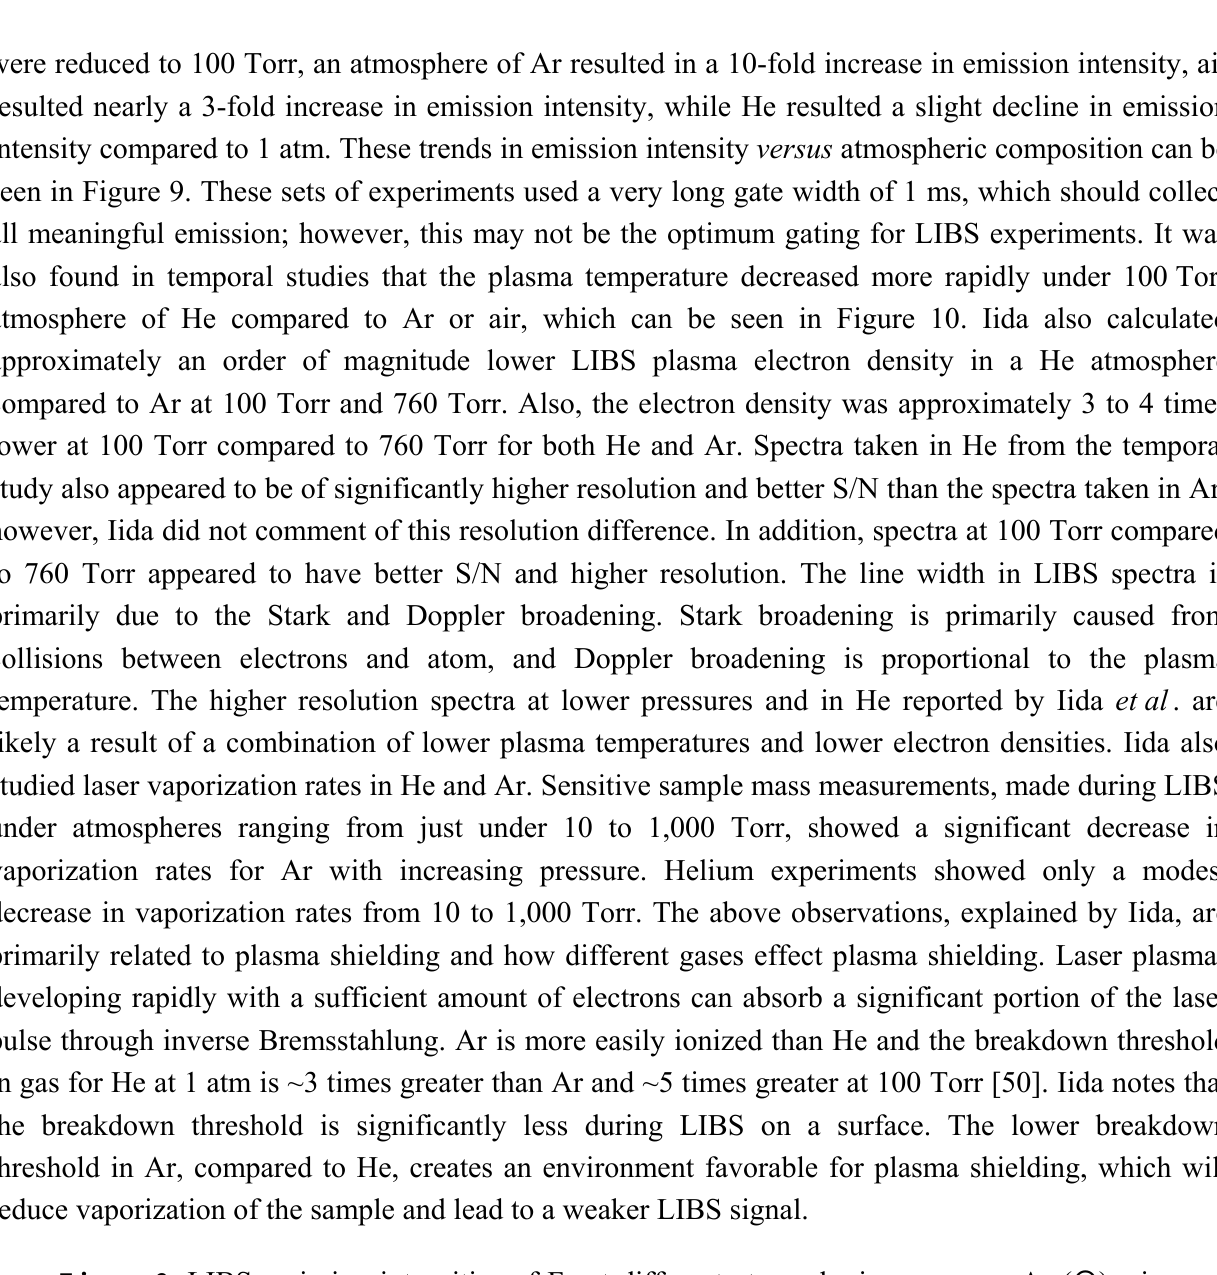
Figure 9. LIBS emission intensities of Fe at different atmospheric pressures, Ar (  ), air (  ), and He (  ). Reprinted from reference